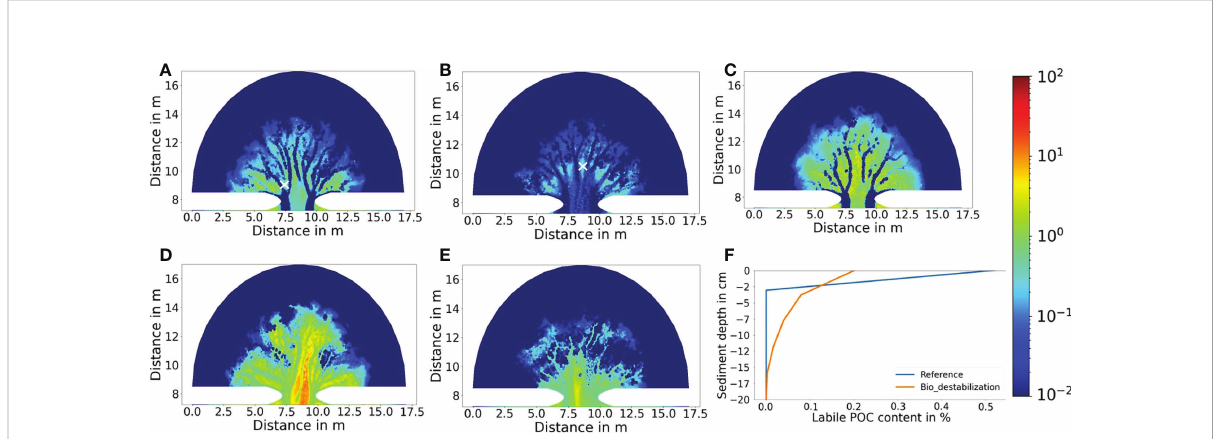
FIGURE 8 Simulated labile POC content in percentage at year 500 for the (A) reference result, (B) the Bio_destabilization scenario, (C) the Bio_stabilization scenario, (D) the Bio_deposition scenario and (E) the Bio_all scenario. (F) Comparison of typical vertical pro fi le of labile POC content in sea fl oor sediment at tidal fl ats between the reference result (exclusion of benthic faunal impact) and the Bio_destabilization scenario (inclusion of bio- mixing). Locations of the sites are indicted by X mark in (A, B) , respectively.